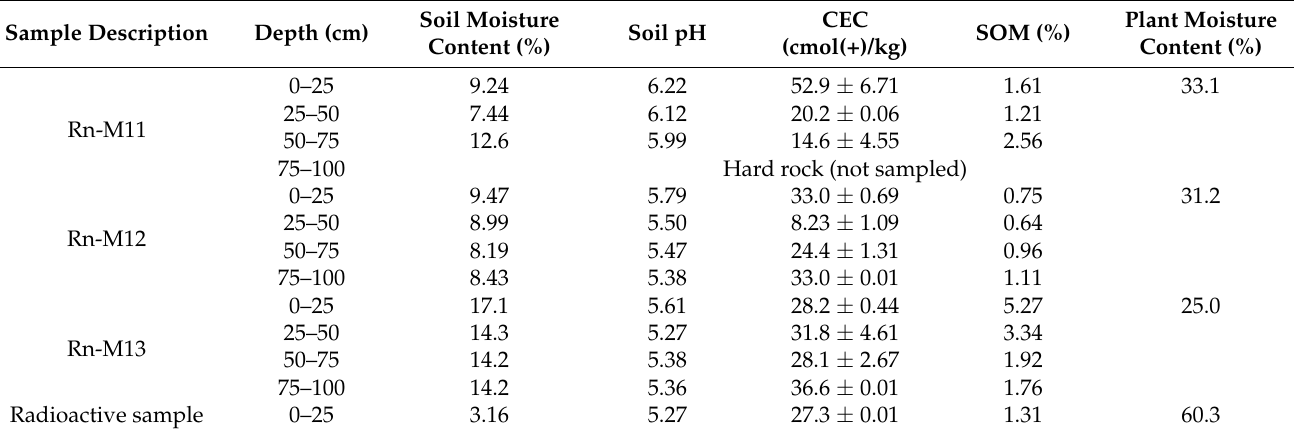
Table A1. Physico-chemical properties that may affect the mobility of elements